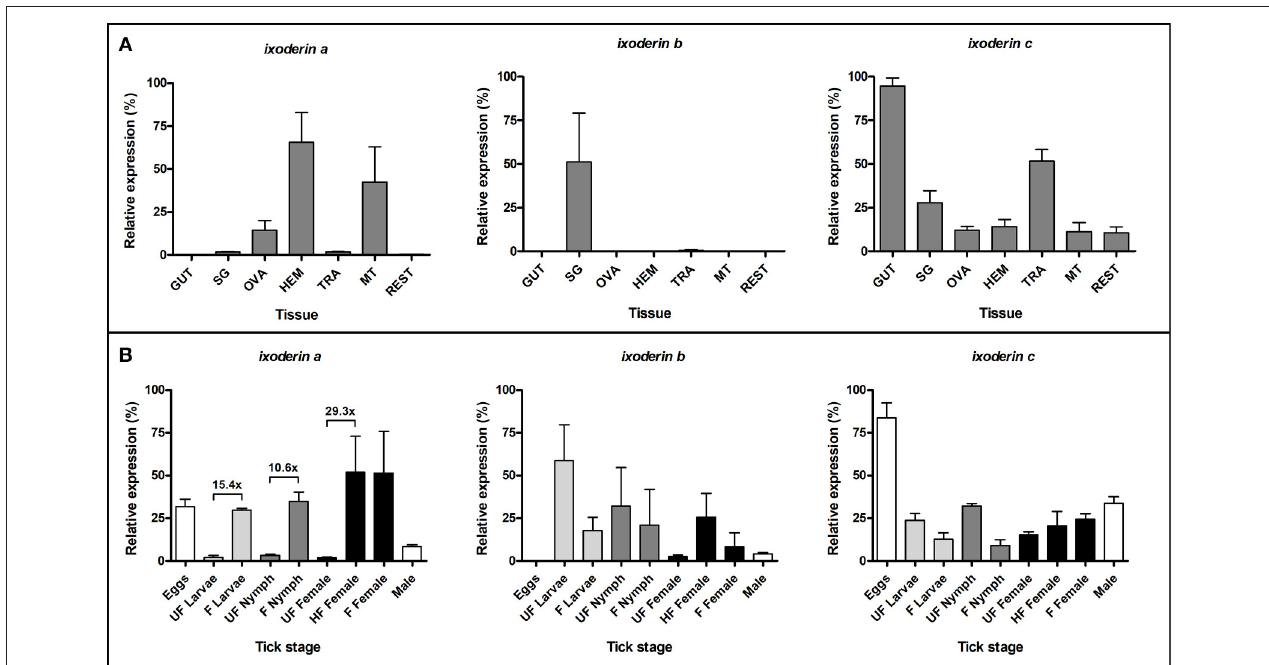
FIGURE 2 | Ixoderins a , b , and c show distinct tissue and stage-specific expression profiles. qRT-PCR analysis was performed on tissues of semi-engorged I. ricinus females (A) and a mixture of ticks from each developmental stage before and after blood feeding (B) . The samples were prepared in three biological replicates. In each graph, cDNA with the highest expression was set as 100% (relative expression). Tick actin and elongation factor were used as housekeeping genes for the tissue and stage-specific profiling, respectively. (GUT) midgut, (SG) salivary glands, (OVA) ovaries, (HEM) hemolymph, (TRA) trachea and fat body, (MT) Malpighian tubules, (REST) rest of the body, (UF) unfed ticks, (HF) half-fed (semi-engorged) adult females fed for 5 days, (F) fully-fed ticks.